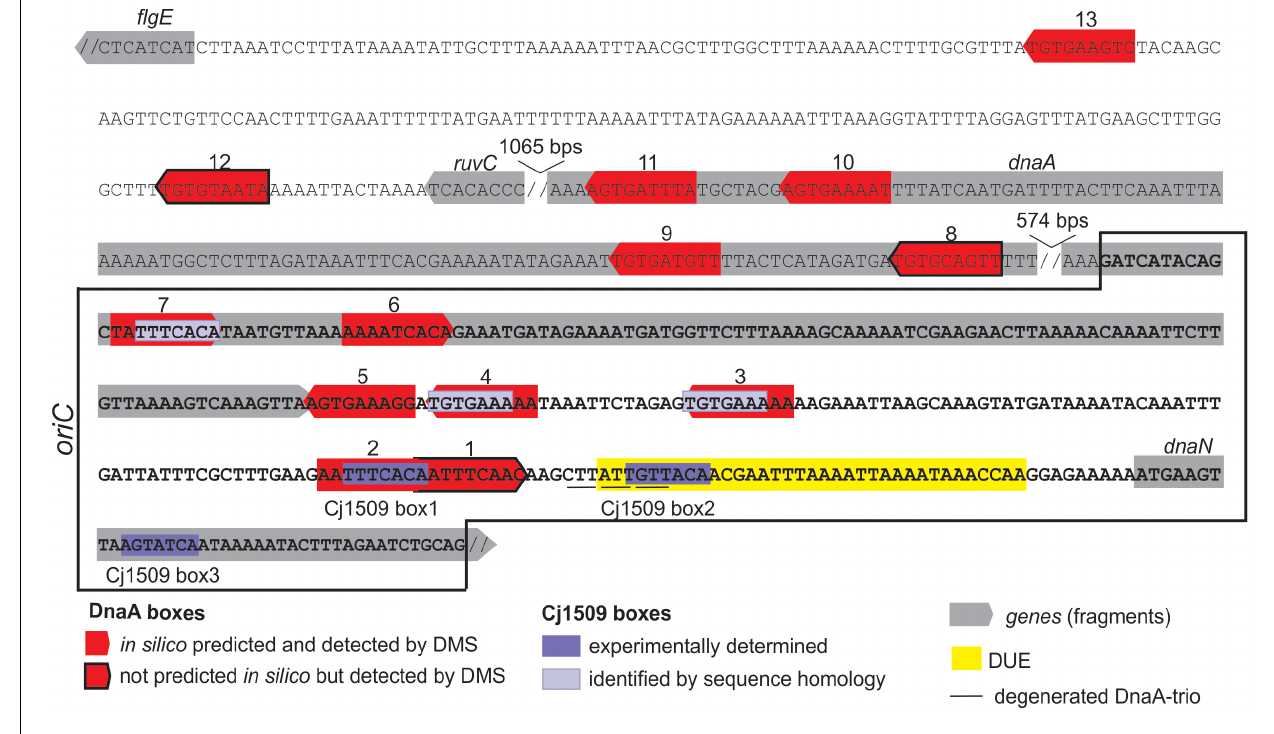
Cj1509 box 3 (5 (cid:48) -AGTATCA-3 (cid:48) ) (each of which has two